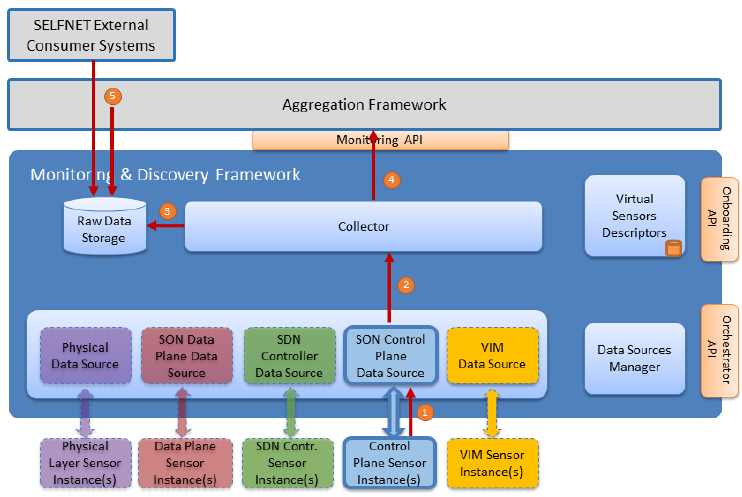
Figure 10. Sensor Monitoring—Metrics and/or Events Workflow.